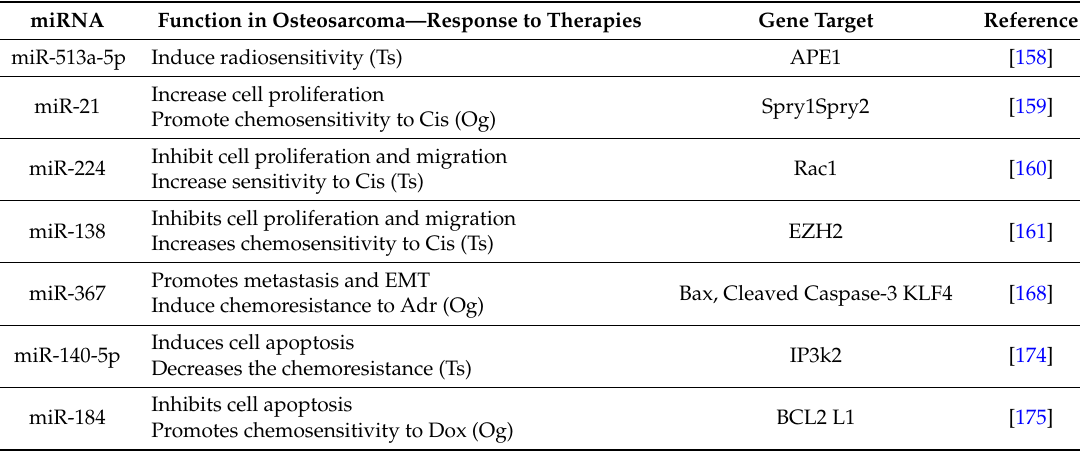
Table 2. Associated miRNAs to response to chemo- and radiotherapy in osteosarcoma. miRNA Function in Osteosarcoma—Response to Therapies Gene